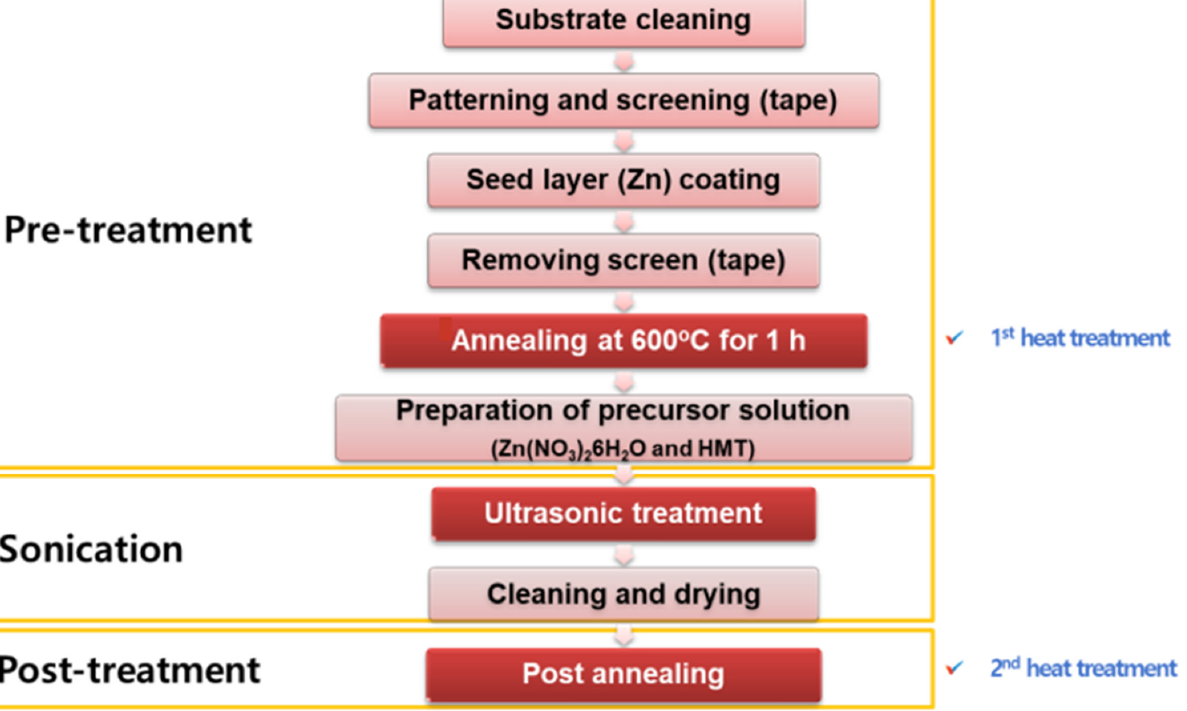
Figure 2. Schematic of the experiment.